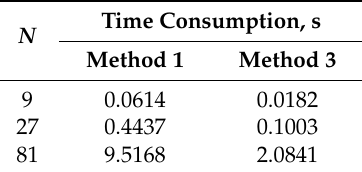
Table 6. Time consumptions of Method 1 and Method 3 for the other three